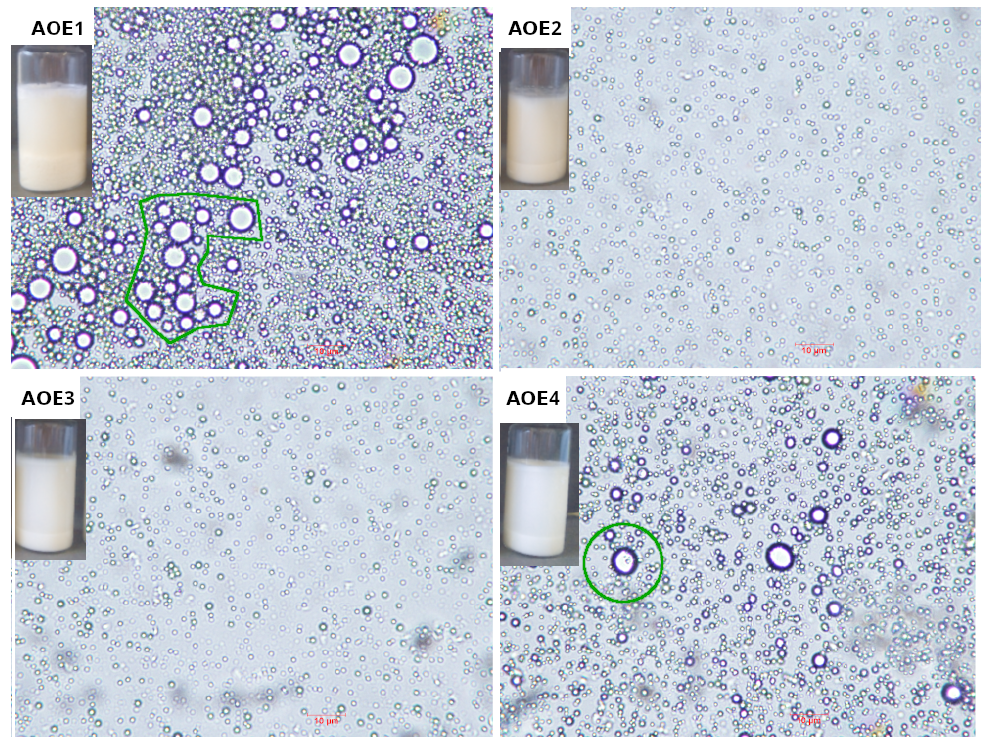
Figure 2. Visual appearance of measuring vials containing avocado oil emulsions stabilized by particulate emulsifiers after fifteen days of storage and optical microscopy (40 × magnification) of avocado oil emulsions: AOE1, AOE2, AOE3, and AOE4. Optical microscopy images of AOE1 and AOE4 samples were taken from the supernatant of the vials, and AOE2 and AOE3 samples were taken from the sediment in the vials. The green circles enclose droplet coalescence. Scale bar of 10 µ m (—).